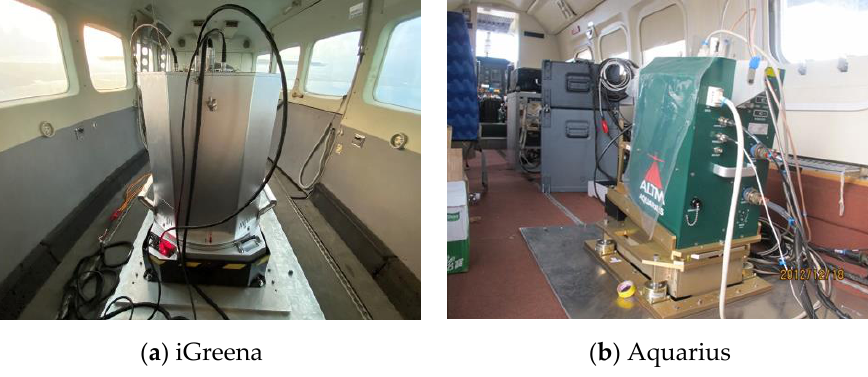
Figure 10. ALB systems used in the experiment. Table 3. Experimental system parameters.